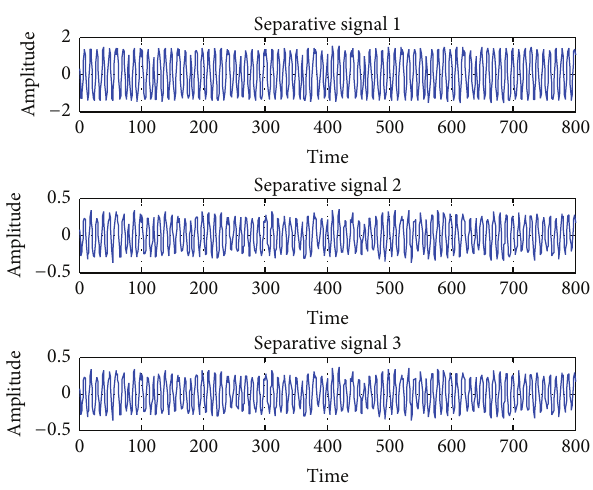
Figure 12: Blind source separation waveform using the proposed improved FastICA with 𝐾 -means algorithm.